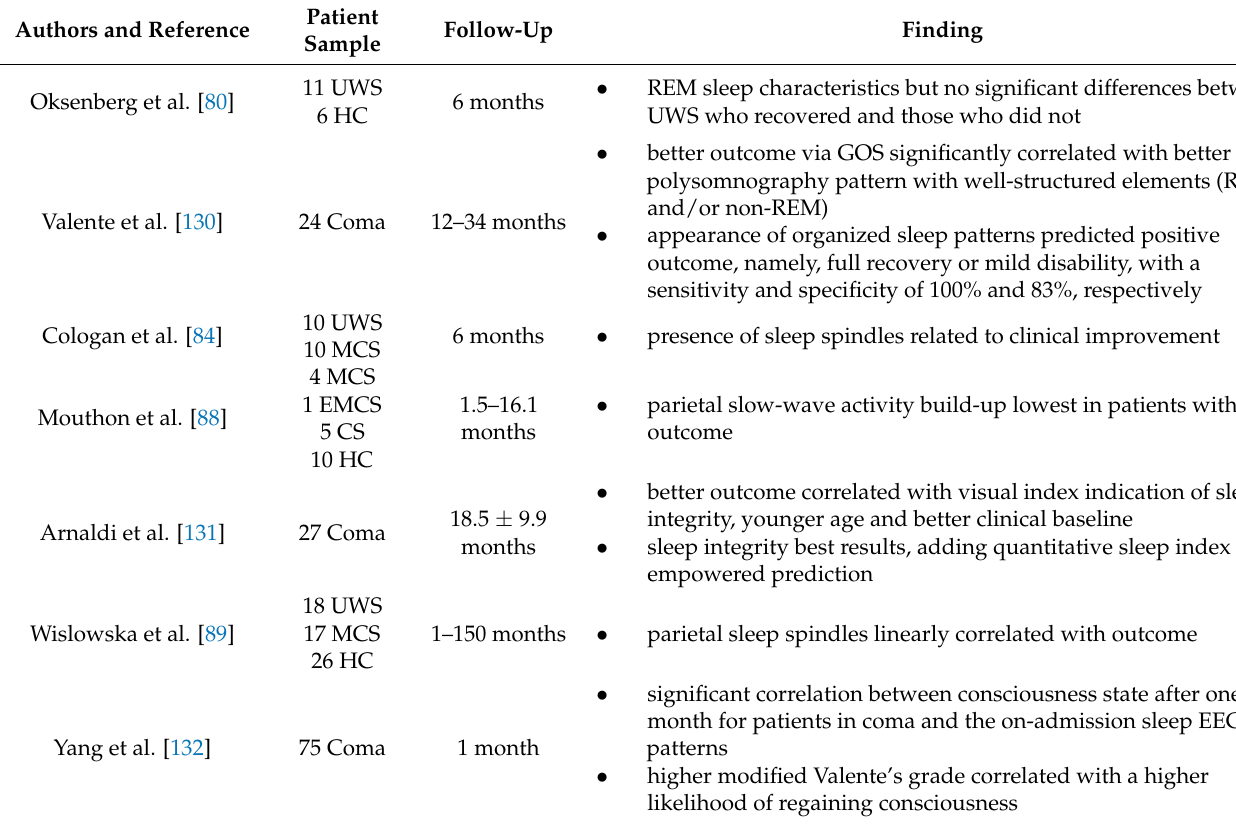
Table 5. Overview of findings for prognosis and sleep patterns; abbreviations can be found in Abbreviation. Authors and